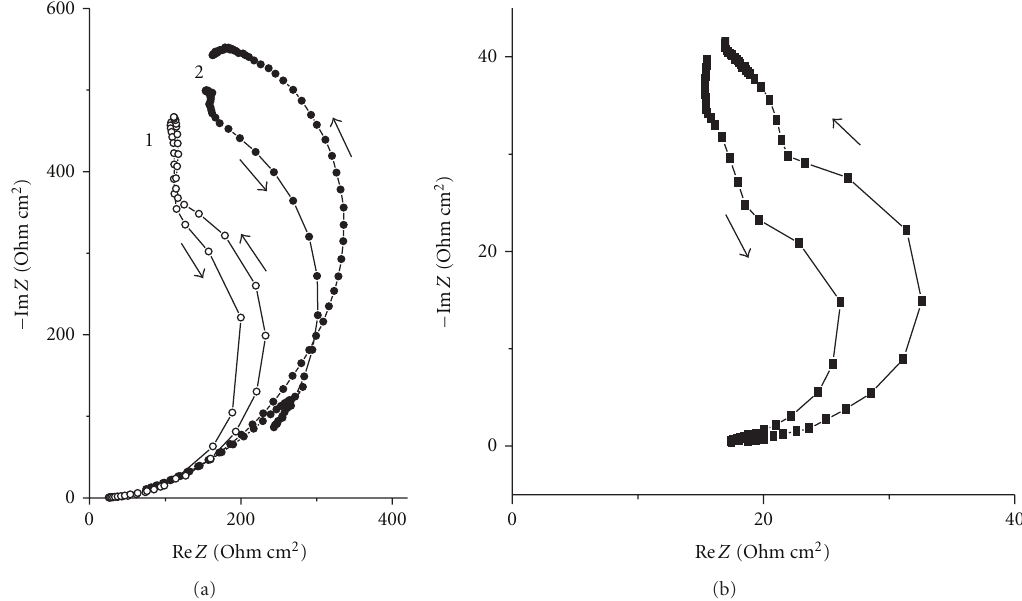
Figure 11: Complex-plane plots of impedance spectra ( E -sweep) in 1M KCl solution, demonstrating the frequency e ff ect on the small arc position. (a) 60 Hz: (1) benzene-free solution and (2) benzene-containing solution. (b) 1000 Hz, benzene-containing solution. Arrows show the direction of potential sweep (0.4–2.5 V).